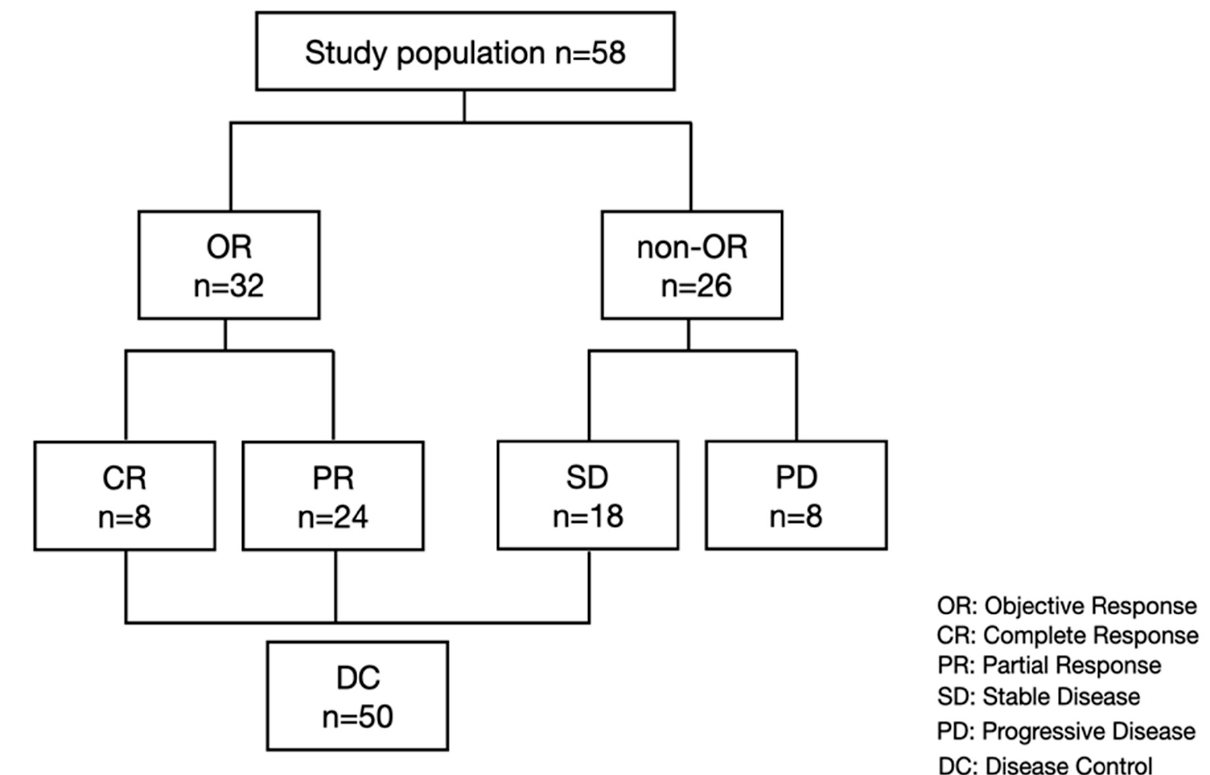
Figure 1. Study flow and treatment response.